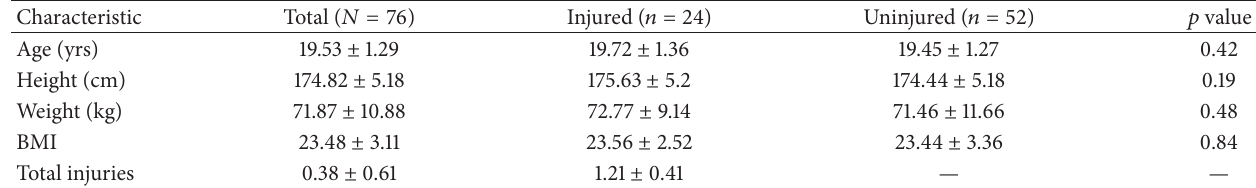
Table 1: Characteristics of the included cohort means and standard deviations (M ± SD).